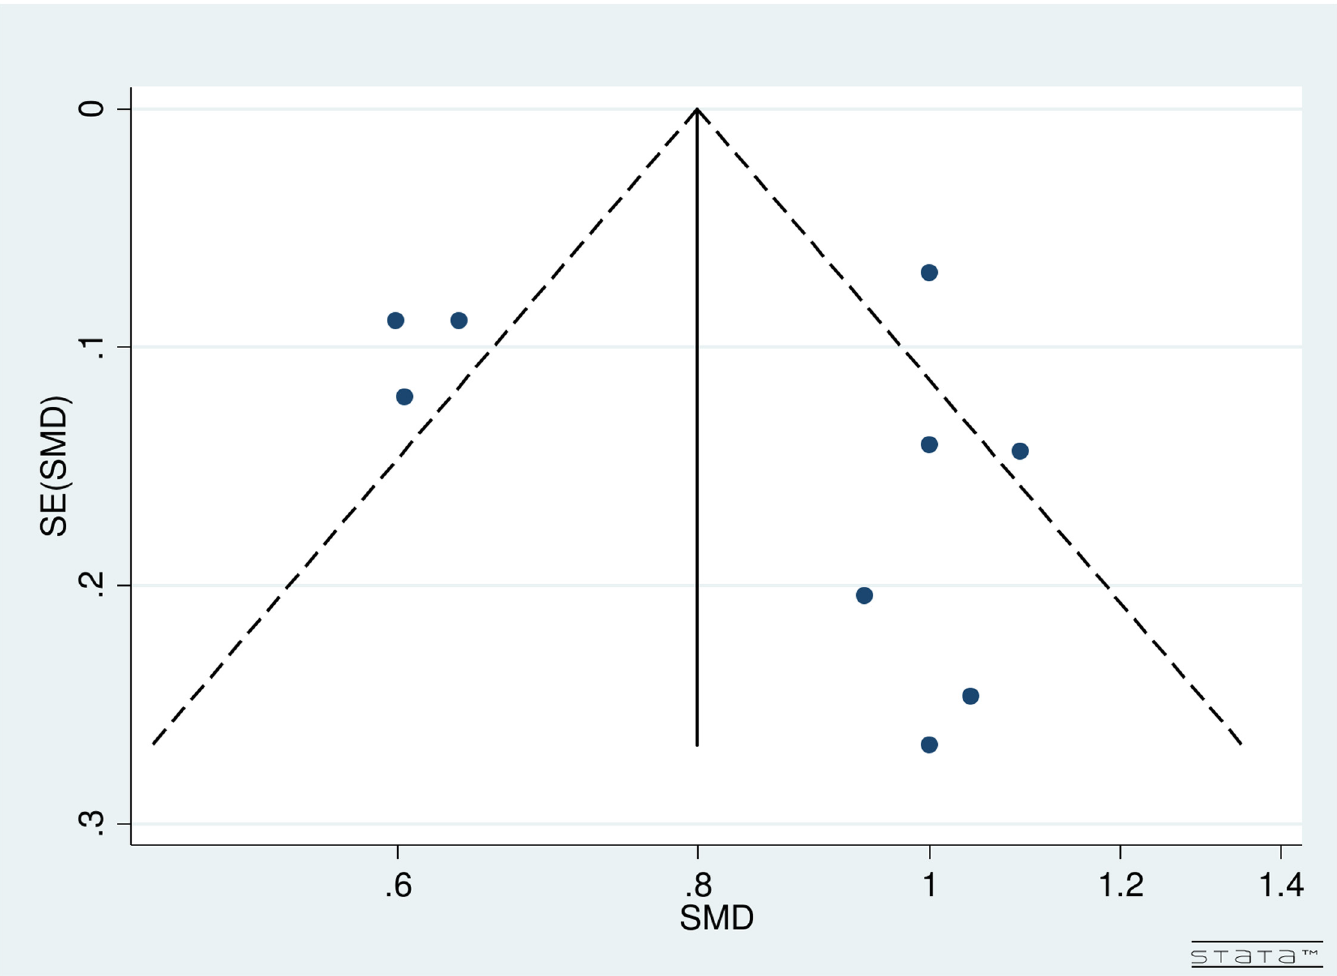
Fig 2. Funnel Plot for Included Studies Evaulating Immediate versus Delayed Sequential Bilateral Cataract